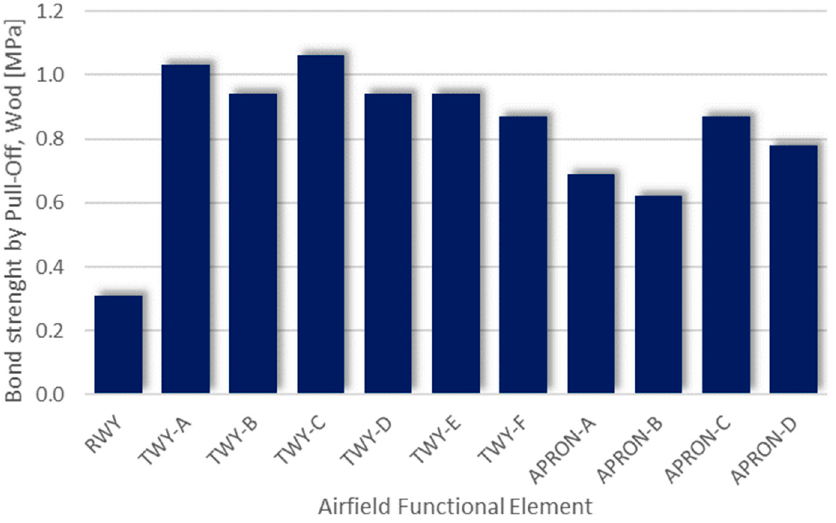
Figure 13. Results of testing the surface layer’s tensile bond strength.